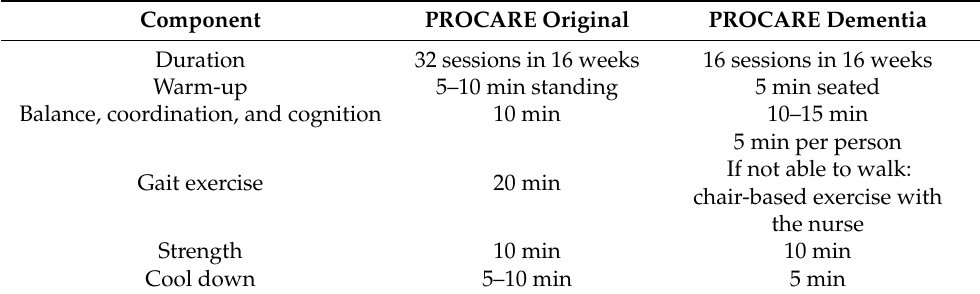
Table 1. Comparison of the multicomponent training PROCARE and PROCARE